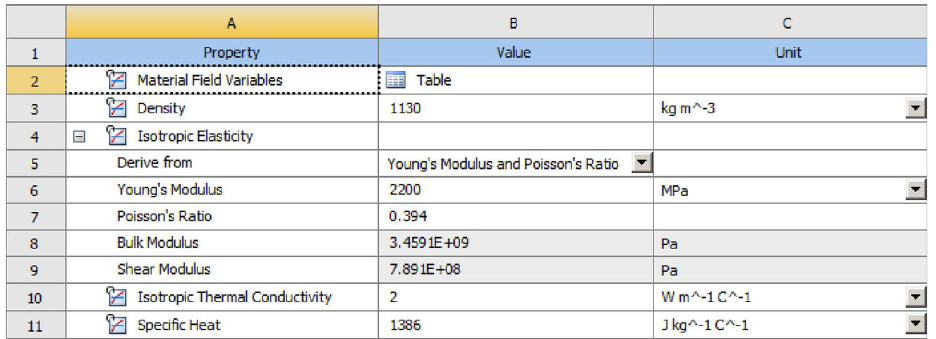
Figure 5. UTR9000 material